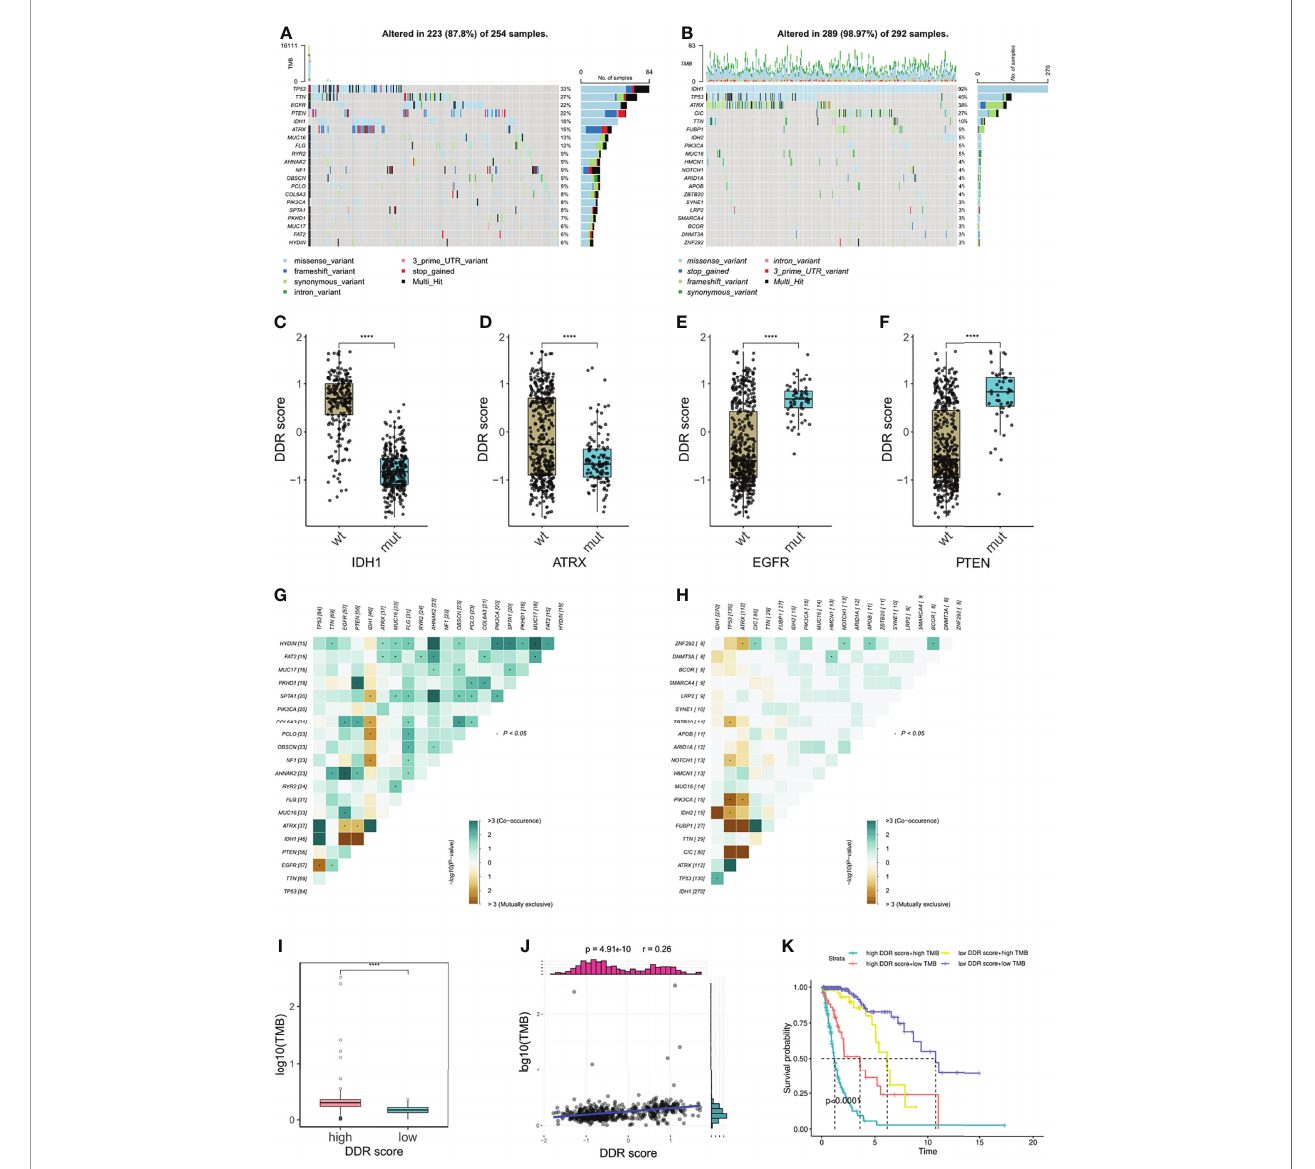
FIGURE 7 | Correlation of DDR score and glioma somatic genome. (A, B) The top 20 frequent somatic mutations in high and low DDR score groups. (C – F) IDH1, ATRX, EGFR, and PTEN mutations were signi fi cantly correlated with DDR score levels. (G, H) Mutual exclusivity and co-occurrence of mutations in high and low DDR score groups. (I) TMB level in high and low DDR score groups. (J) The correlation of DDR score and TMB. (K) The Kaplan-Meier survival analysis for patients strati fi ed by both DDR score and TMB. ****p <